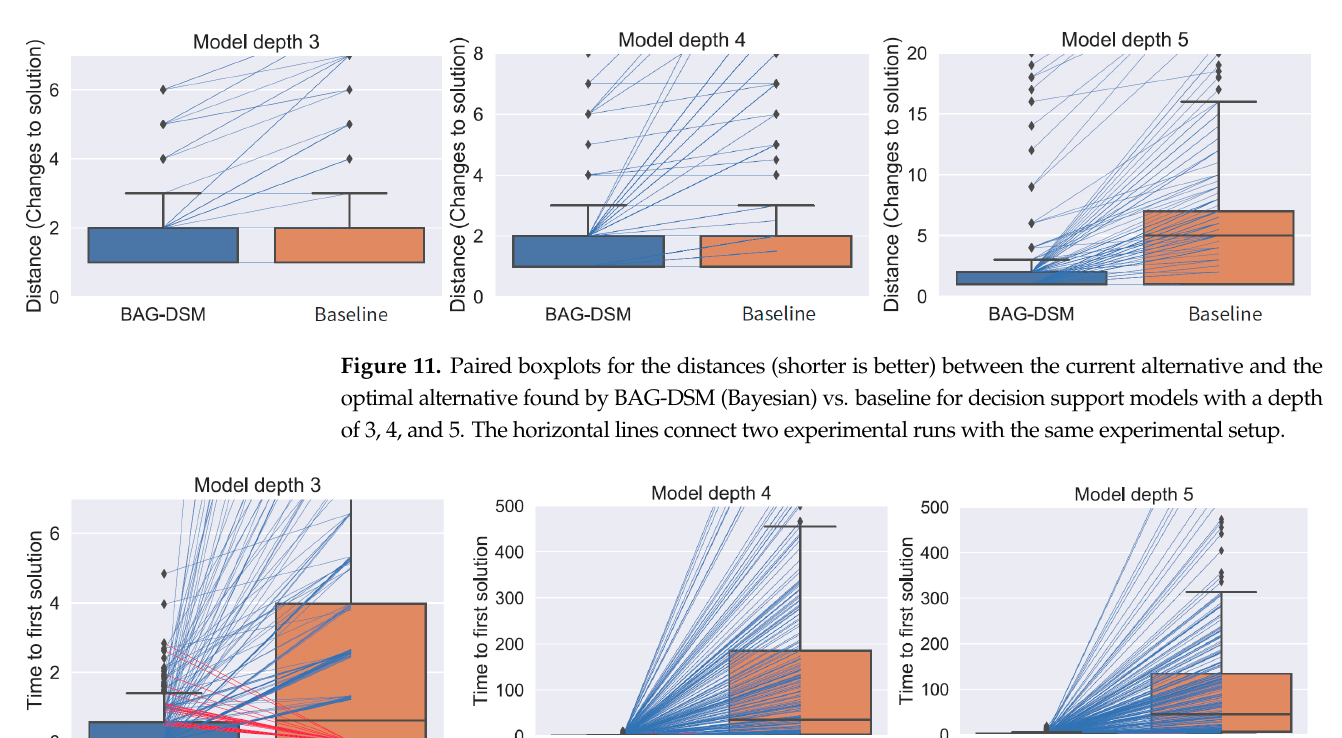
Figure 11. Paired boxplots for the distances (shorter is better) between the current alternative and the optimal alternative found by BAG-DSM (Bayesian) vs. baseline for decision support models with a depth of 3, 4, and 5. The horizontal lines connect two experimental runs with the same experimental setup.